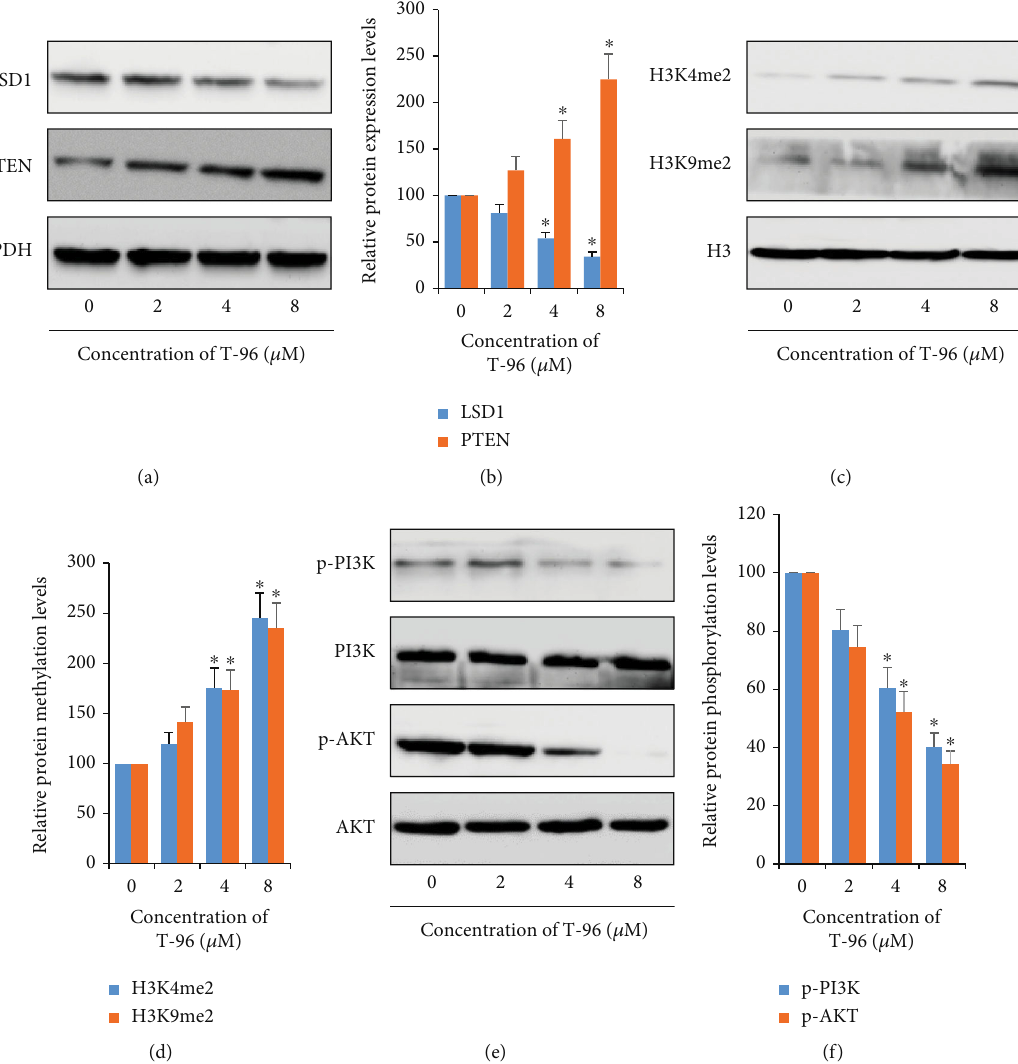
Figure 3: T-96 inhibited LSD1-mediate cell signal in the highly metastatic TNBC SUM-1315 cells. (a, b) T-96 inhibited LSD1 and its target protein expression by Western Blot; (c, d) LSD1 increased Histone H3K4 and Histone H3K9 methylation by Western Blot; (e, f) LSD1 inhibited PI3K/AKT cell signaling pathway. Values are statistically signi fi cant at ∗ P < 0 : 05